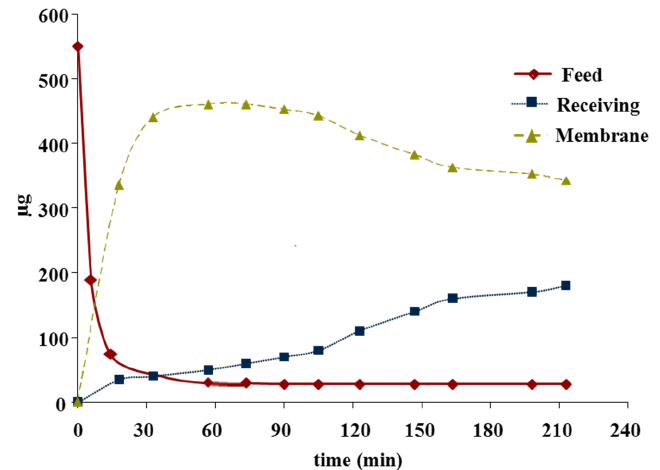
Figure 3. Distribution of Cr(VI) in the feed, membrane, and receiving solutions set on recirculation. Carrier, [( − )-DMEB] = 30 mM, membrane solution volume = 50 mL; feed, [Cr(VI)] = 10 mg/L, feed solution volume = 55 mL; receiving, [HNO 3 ] = 0.75 M, receiving solution volume = 250 mL.